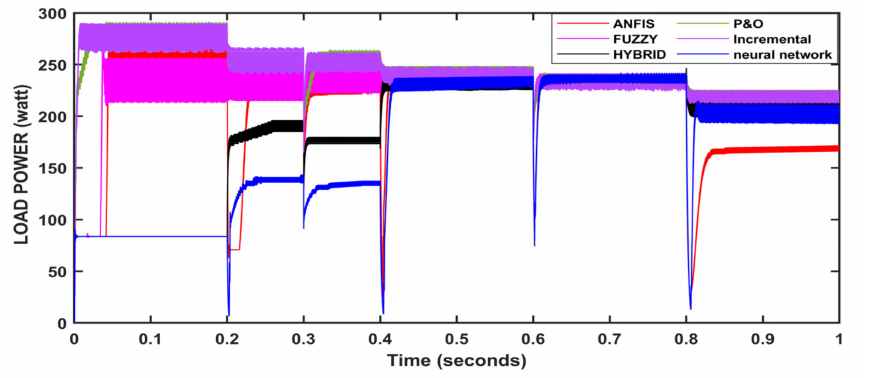
Figure 44. Controller performance at various temperatures and varying loads; E = 1000 W/m 2 .